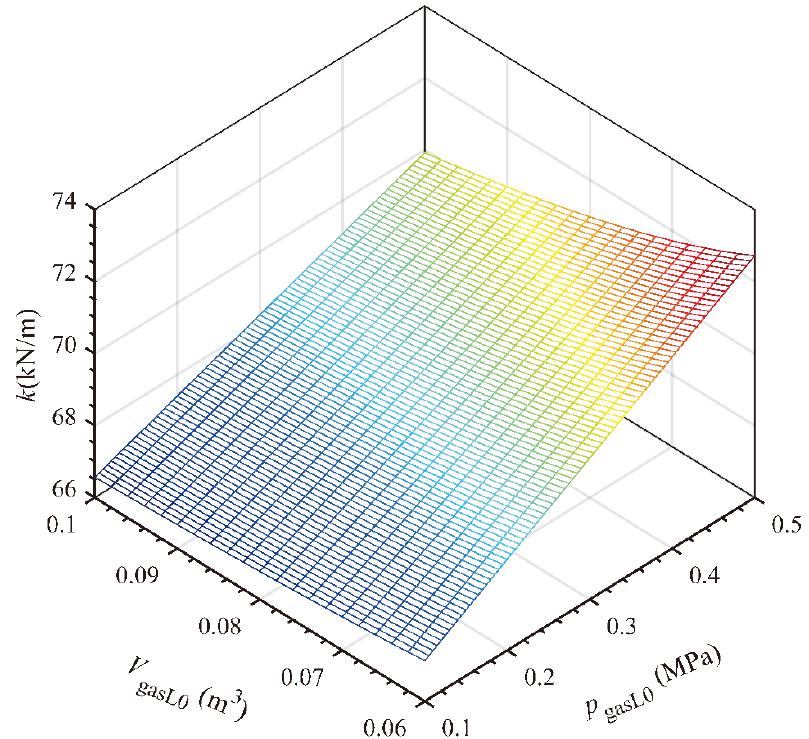
Figure 11. Effects of the pressure and volume of the low-pressure accumulator, p gasL0 and V gasL0 , on the stiffness coefficient, k.